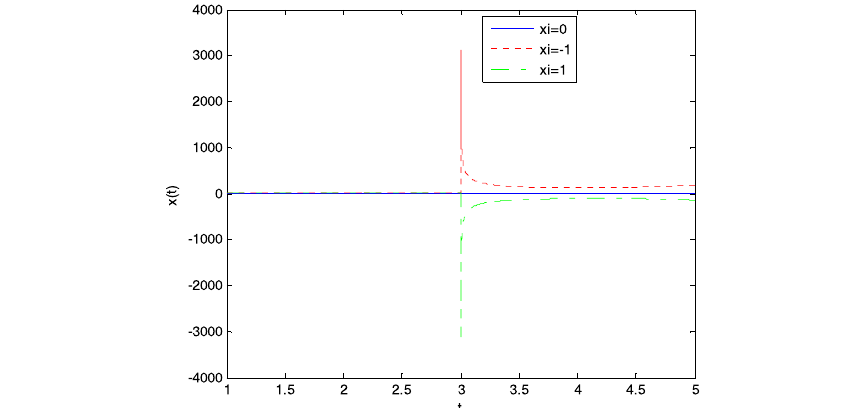
Figure 4 The solution trajectory of system (5.1) with ρ = 2